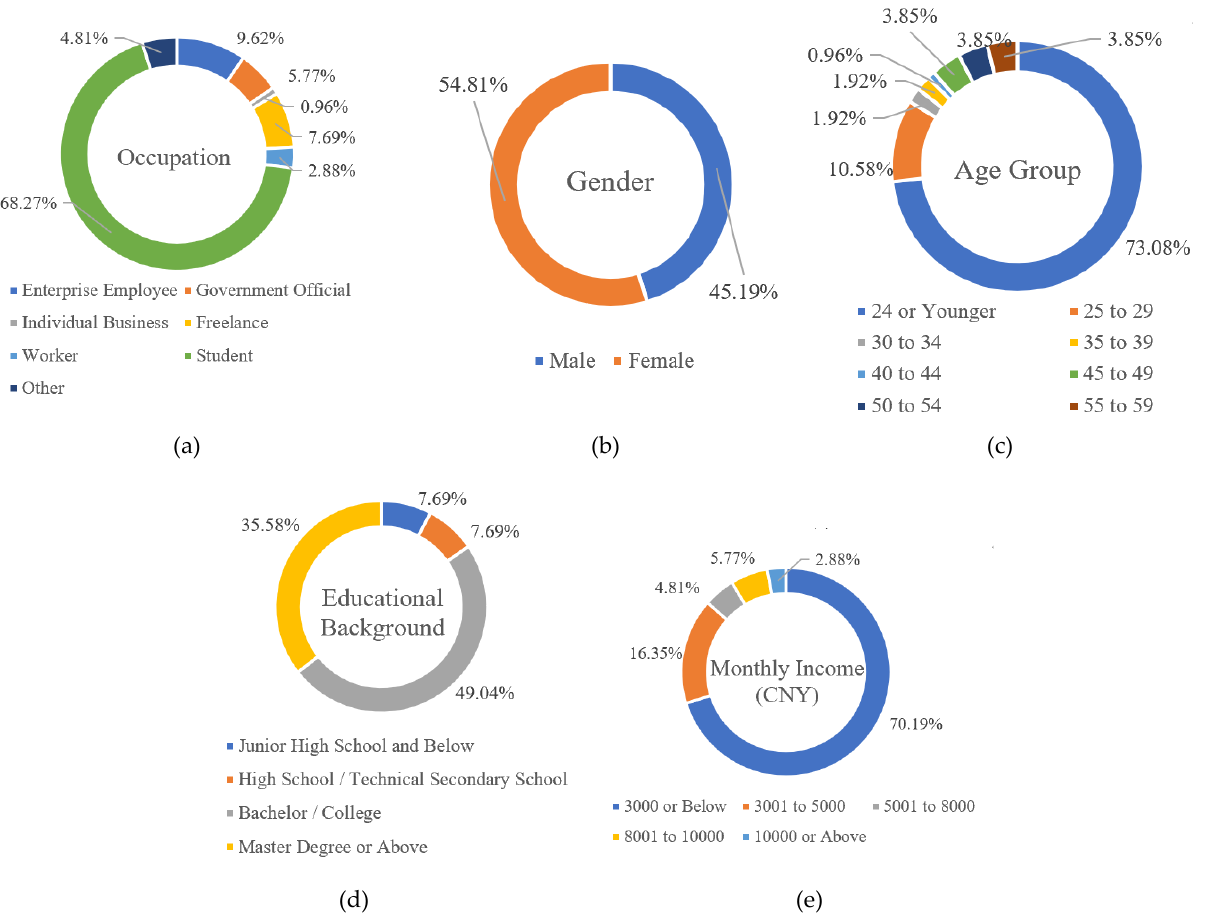
Figure 3. Demographic characteristics of the sample: ( a ) occupation; ( b ) gender; ( c ) age group; ( d ) educational background; ( e ) monthly income.